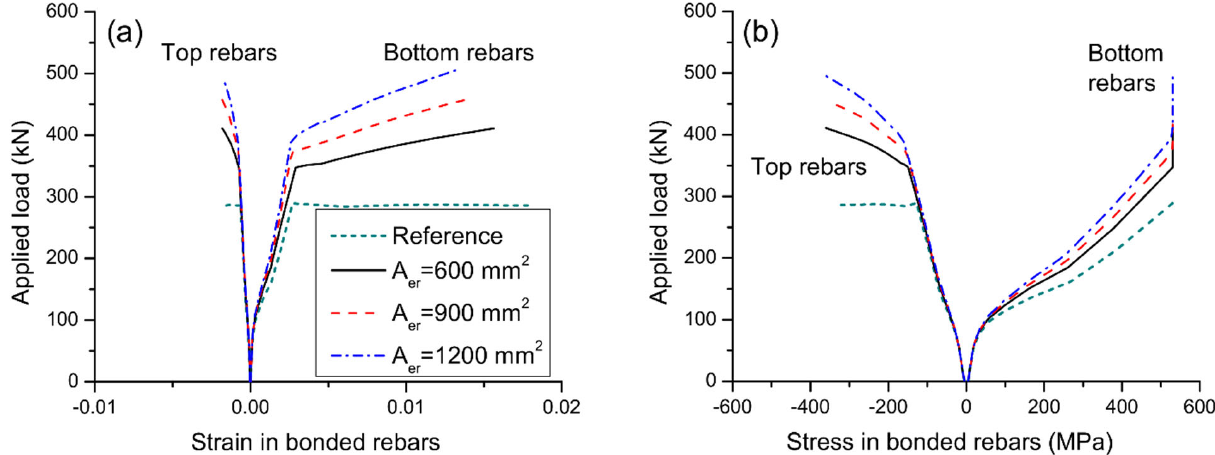
Figure 10. Effect of reinforcement area on the behavior of bonded rebars at midspan. ( a ) development of rebar strain; ( b ) development of rebar stress.